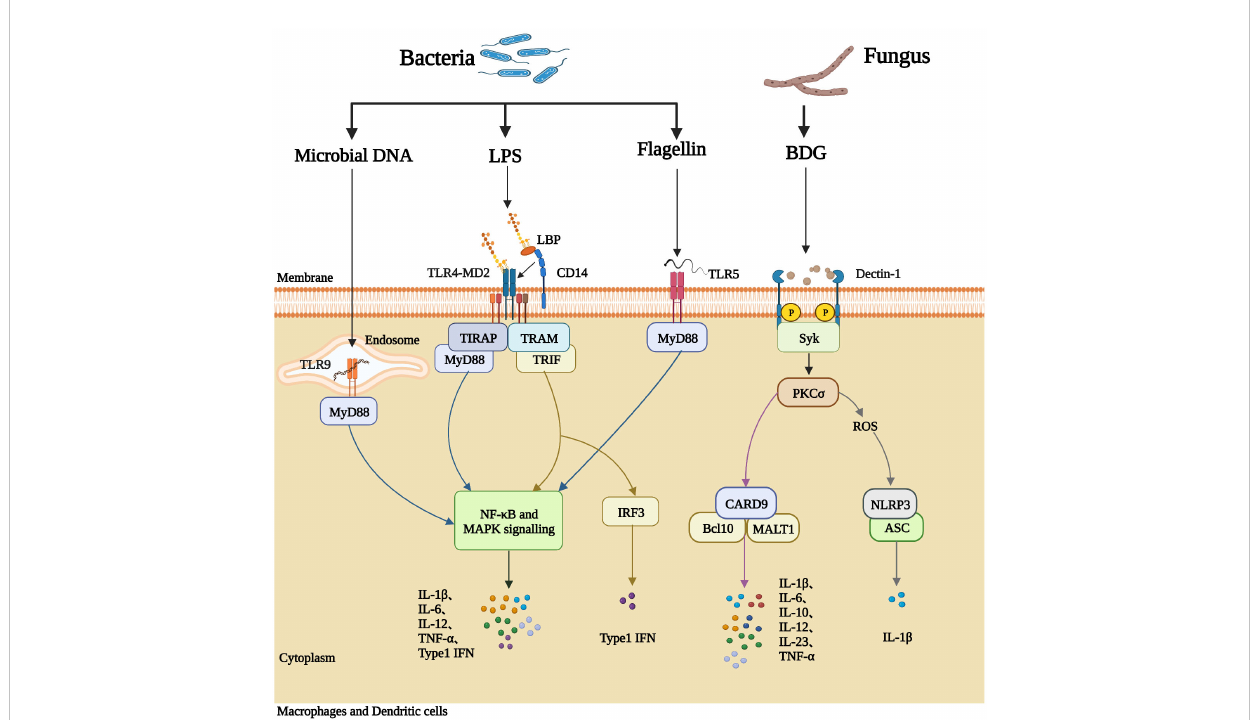
FIGURE 2 Microbial products induce immune activation in PLWH. Macrophages and dendritic cells express pattern recognition receptors (PRRs) on the cell membrane, which can recognize pathogen-associated molecular patterns (PAMPs) on the surface of microorganisms, including bacterial DNA, LPS, fl agellin, and fungal BDG, and subsequently generate in fl ammatory responses. LPS-binding protein (LBP) and CD14 deliver LPS to the signaling receptor complex TLR4/MD2 on the outer member of the cell. The TLR4/MD2/LPS complex activates the NF- k B signaling pathway and the mitogen-activated protein kinase (MAPK) signaling pathway, causing the synthesis and release of pro-in fl ammatory cytokines into the blood (such as IL-6, IL-12, TNF- a , and IL- 1 b ). Membrane TLR5 recognizes bacterial fl agellin and activates NF- k B through MyD88. Bacterial DNA can be recognized by TLR9 located in the endosome, activating the MyD88-dependent pathway. BDG from fungi is recognized by the C-type lectin receptor Dectin-1 and mediates in fl ammatory cytokine production by activating Syk-dependent pathways. The downstream signal PKC s from Syk